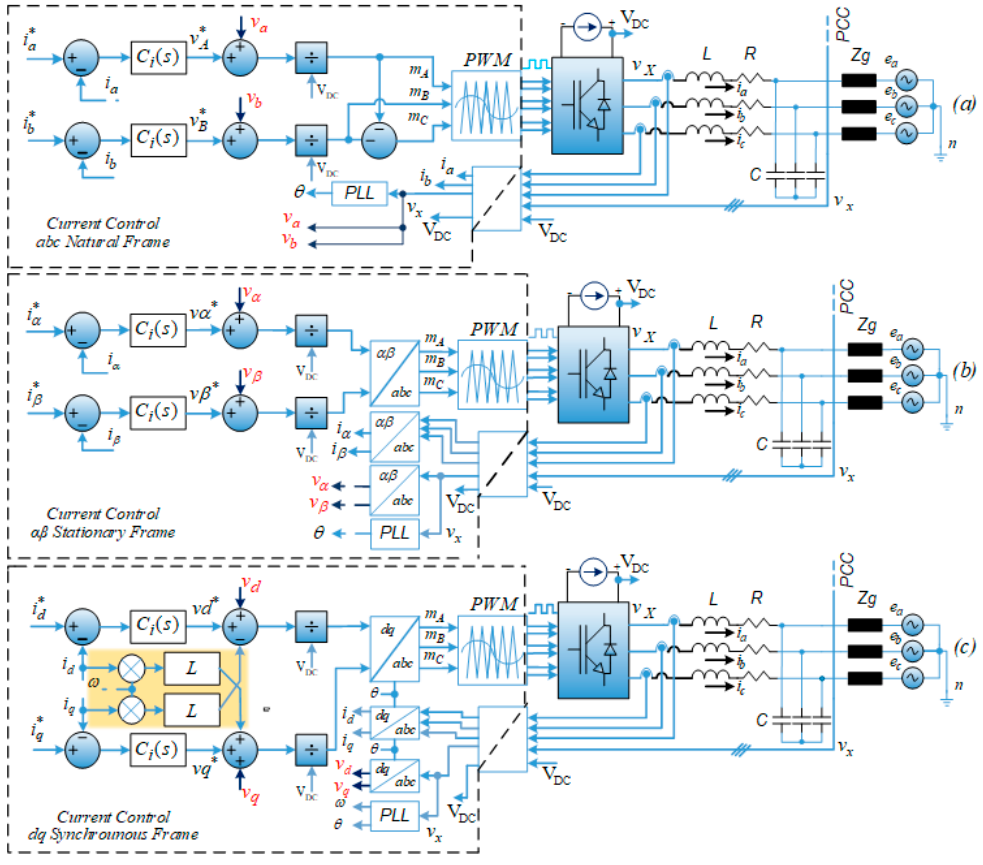
Figure 4. Current control scheme for three-phase three-wire grid-tied VSC. ( a ) abc-frame, ( b ) αβ - frame, and ( c ) dq ‐ frame.